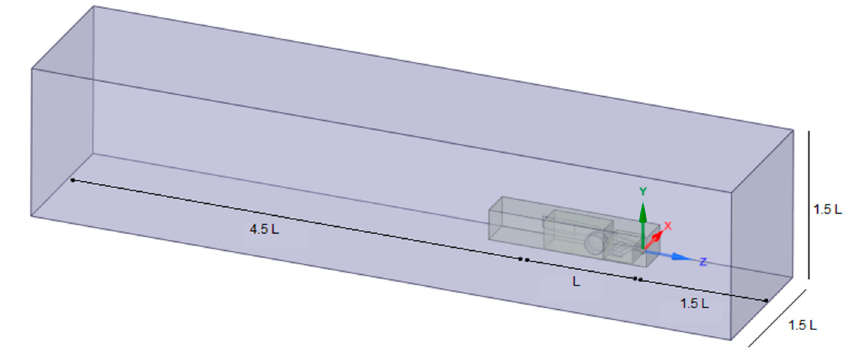
Figure 2. Computational domain dimensions.